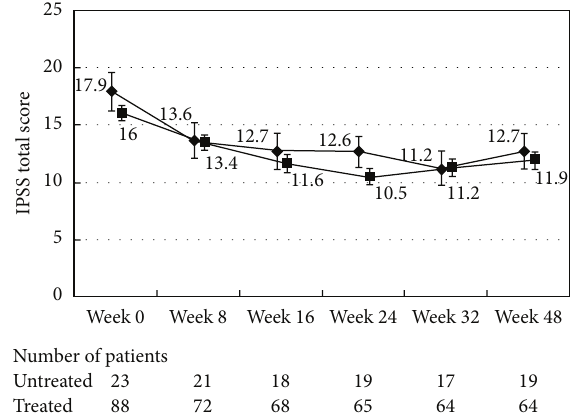
Figure 1: International Prostate Symptom Score total score. The scores in the patients treated with an 𝛼 1-blocker or anticholinergic agent( ◼ )andtheuntreatedpatients( ⧫ )areshown.Thevaluesarethe least squares (LS) mean ± standard error (SE). 𝑃 = 0.1747 (repeated ANOVA).